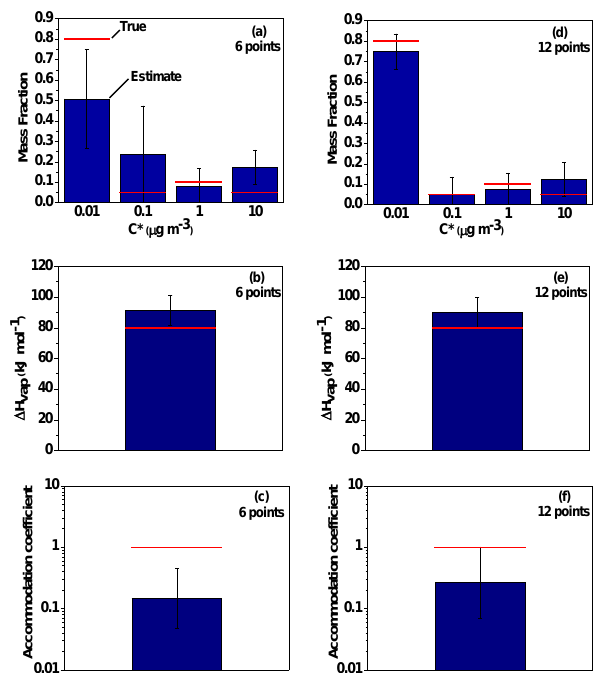
Figure 4. Estimated (bars) and true (red lines) parameter values for an OA with 80% 0.01 μg m -3 , 5% 0.1 μg m -3 , 10% 1 μg m -3 , 5% 10 μg m -3 , ΔH vap =80 kJ mol -1 and a m =1 for: 6 measurements (a) volatility distribution, (b) ΔΗ vap , (c) a m , and using 12 measurements for: (d) volatility distribution, (e) ΔΗ vap and (f) a m . The error bars represent the uncertainty of the estimated value.